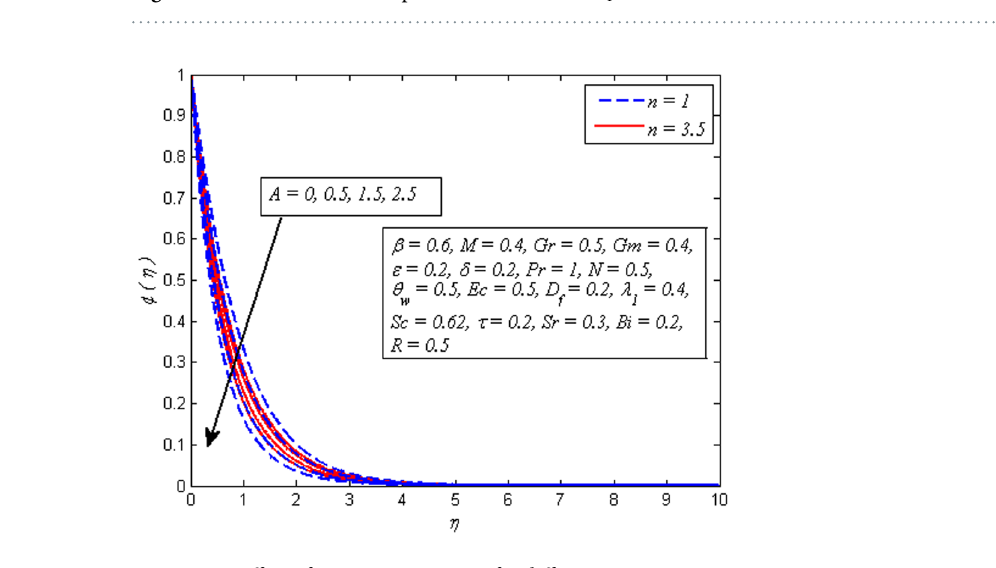
Figure 18. Effect of Bi on temperature for different λ 1 .